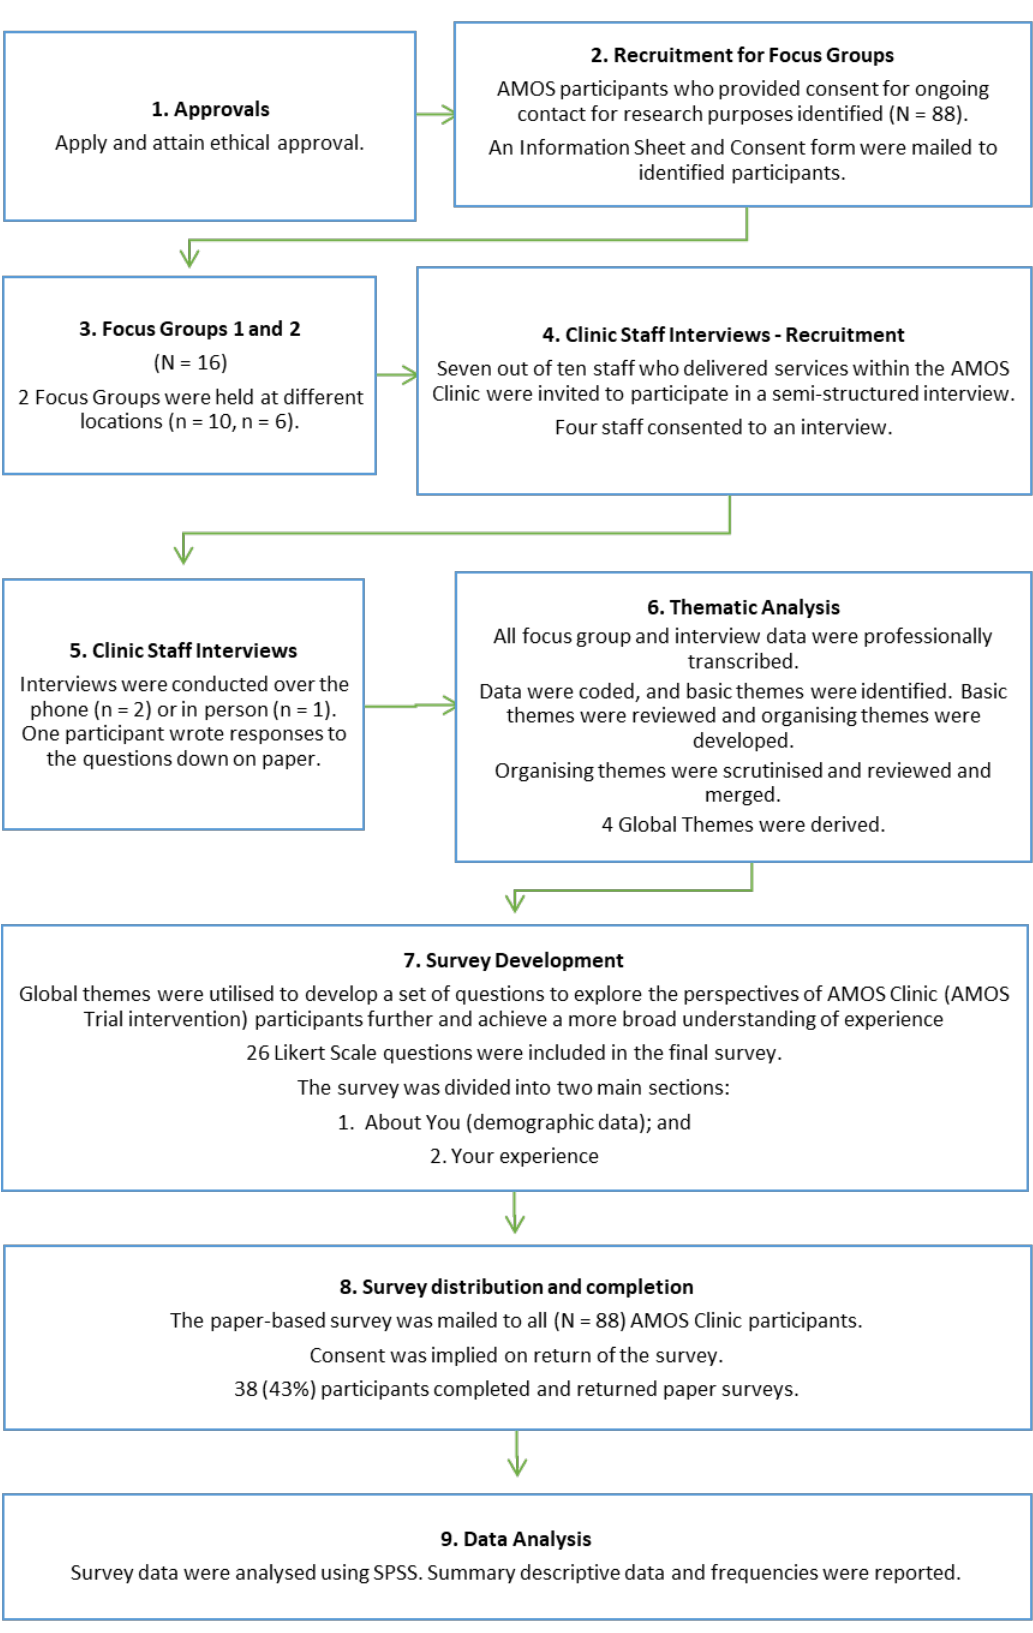
Figure 1. Methods and participants. N: whole group; n: sample.